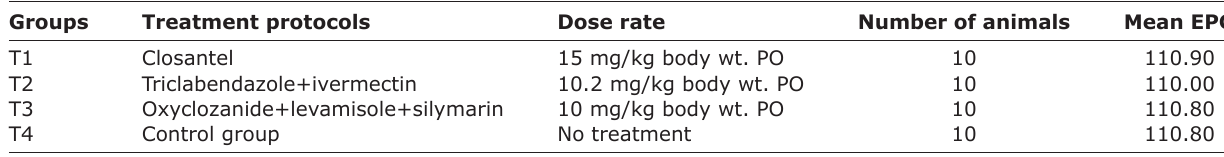
Table-1: Treatment protocols to study the efficacy of various anthelmintics in fasciolosis infected goats of South Gujarat.